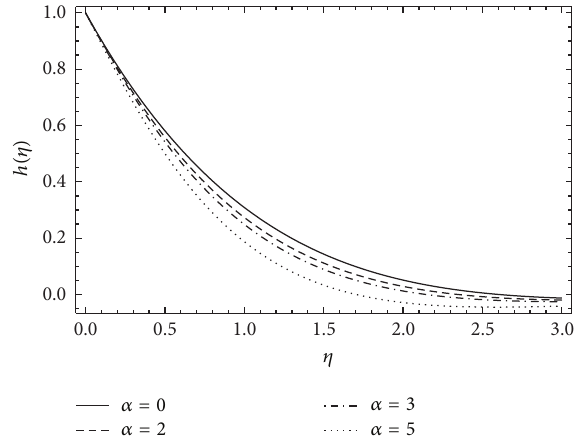
Figure 10: The influence of the rotation parameter 𝛼 on ℎ(𝜂) for 𝜆 = 1 , ℏ = −0.1 .